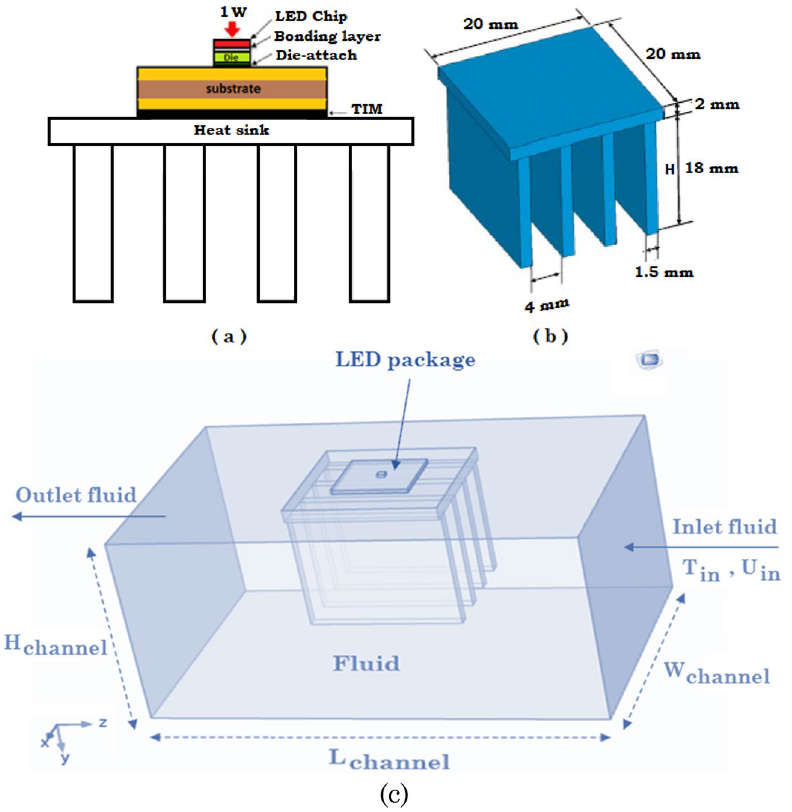
Figure 1. ( a ) Structure of the LED package; ( b ) Sample Dimensions of heat sink, ( c ) Geometry of LED cooling by finned micro-channel filled by nanofluid (COMSOL Multiphysics 5.6, https:// www. comsol. com).